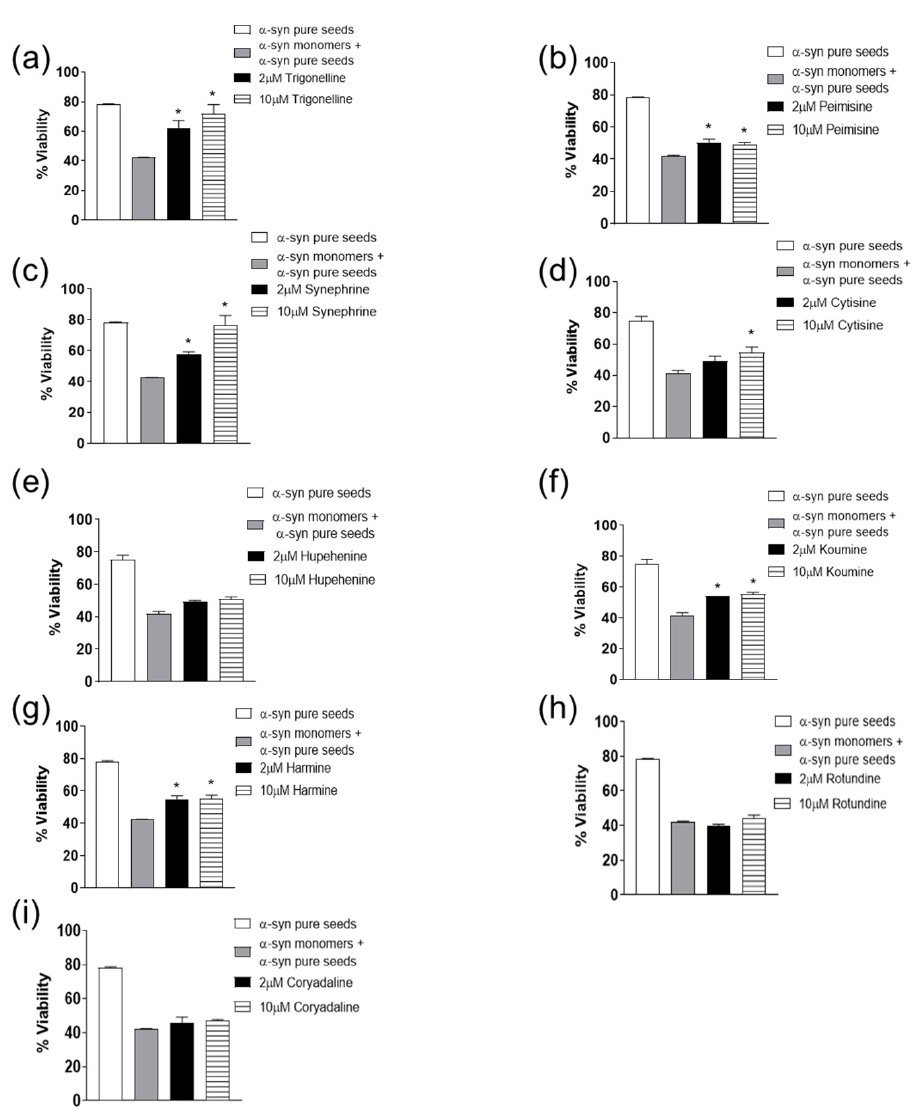
Figure 6. Estimation of viability on WT SH-SY5Y human neuroblastoma cells by the MTT assay. The results are expressed as percentage of the untreated cells. The cells were treated with 0.01 µM of α -syn pure seeds and 10 µM of α -syn monomers with or without 2 and 10 µM of compounds ( a – h ) for 48 h prior to MTT addition (average of 3 wells ± standard deviation). Statistical analysis was performed using One-way ANOVA with Tukey’s multiple comparison testing (* p < 0.05).